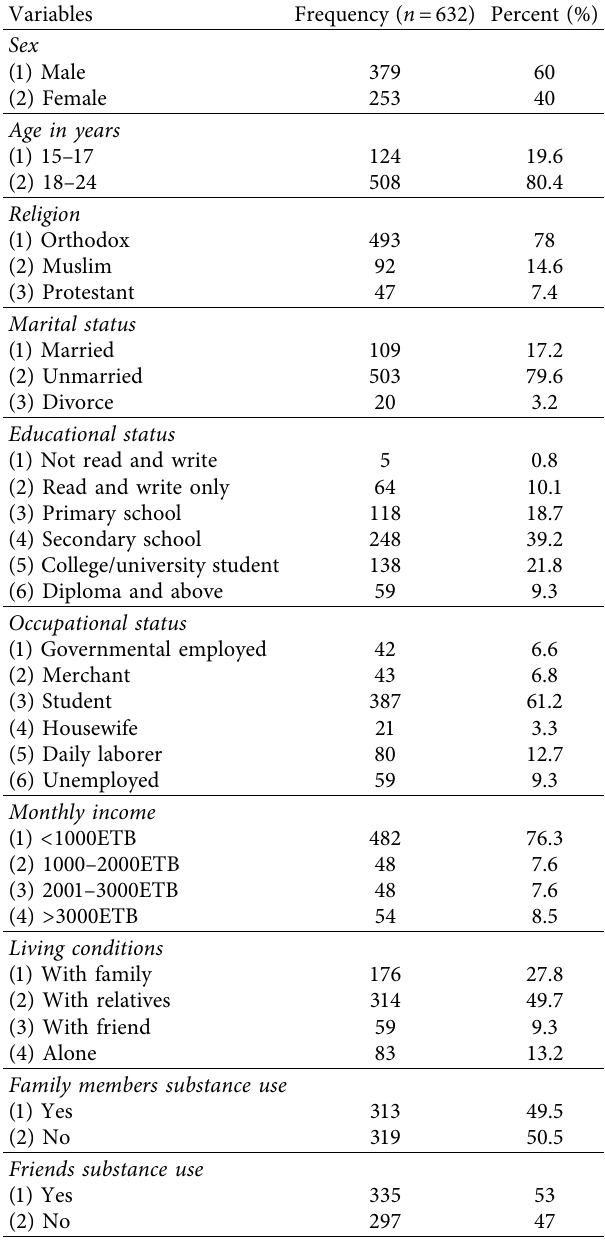
Table 1: Socio-demographic characteristics of study participants among youths at selected administrative towns, North Shewa Zone, Amhara regional state, Ethiopia, 2020